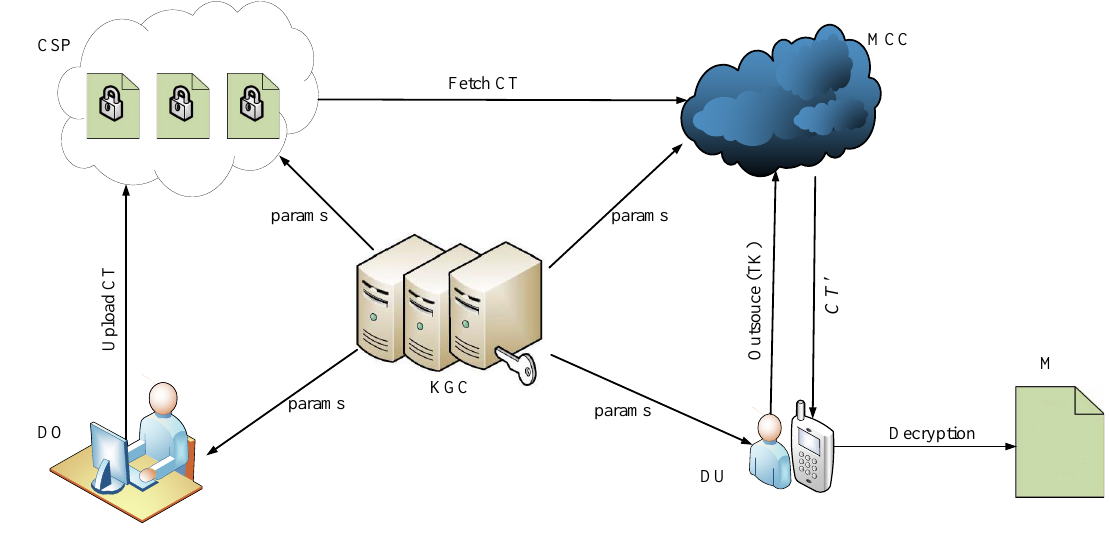
Figure 1. System model of our